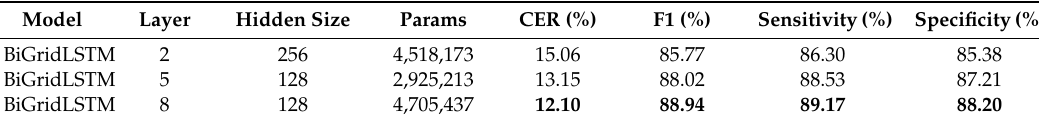
Table 4. CER comparison of BiGridLSTM models of different numbers of layers. The bold data in table indicates the minimum CER and highest sensitivity, specificity, and F1 in the